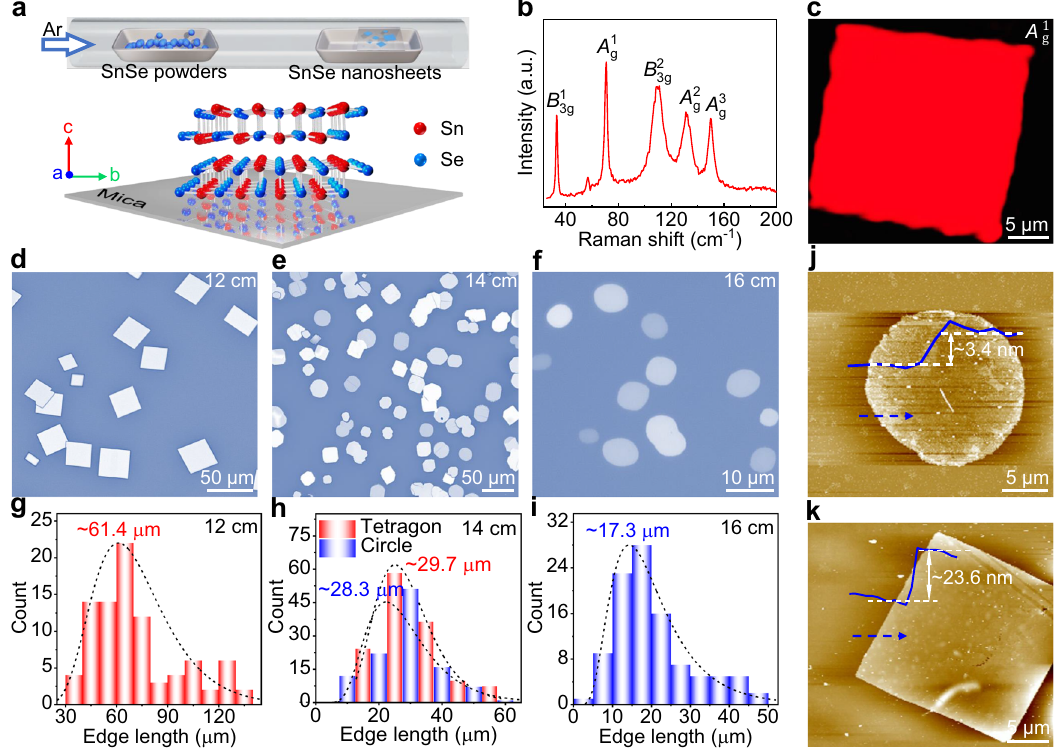
Fig. 1 | Controllable synthesis of thickness-tunable SnSe nanosheets on mica. a Schematic diagram of the growth process and crystal structure of SnSe on mica. b Ramanspectrumofas-grownSnSeonmica. c Ramanintensitymappingimageof A 1 g modeforatetragonalSnSenanosheet,showingitsthicknessuniformity. d – f